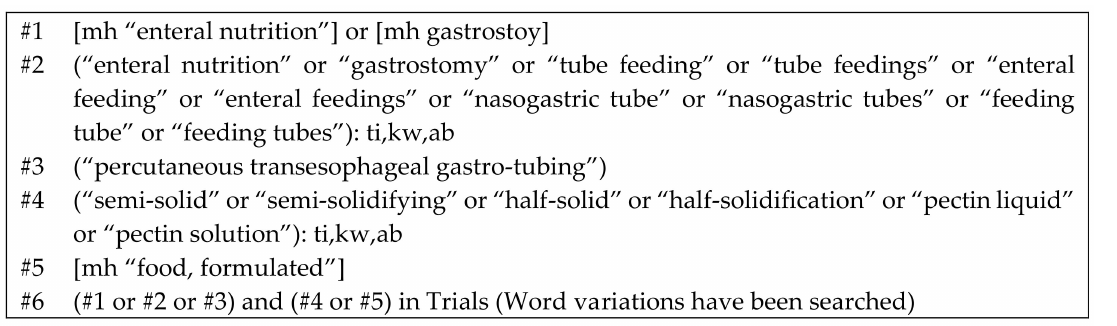
Figure A1. CENTRAL search